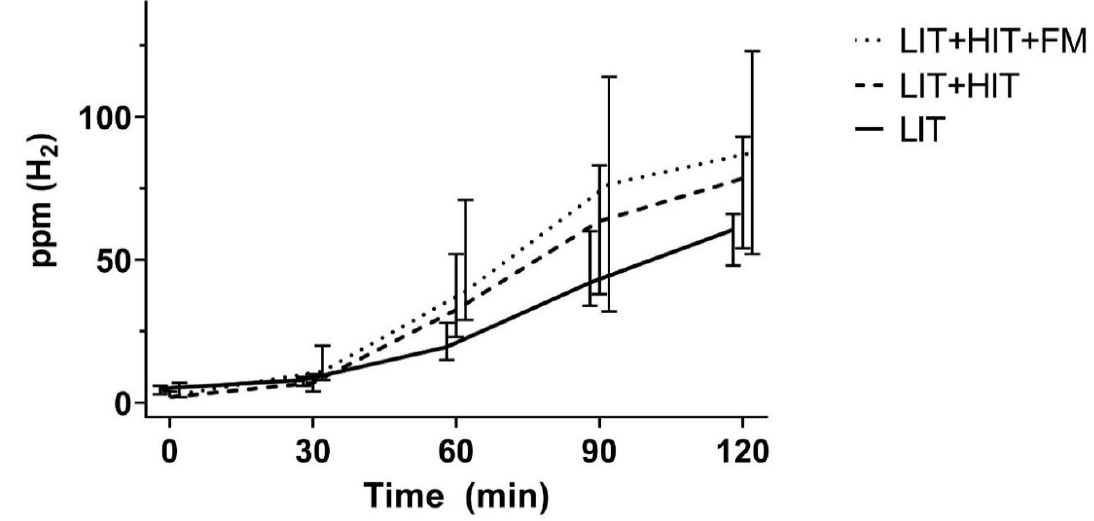
Figure 2. Medians and 95% confidence intervals of rising H 2 ppm during lactose breath tests in 170 LIT patients with >20 ppm increase of expiratory H 2 from baseline. Included are 74 LIT-only